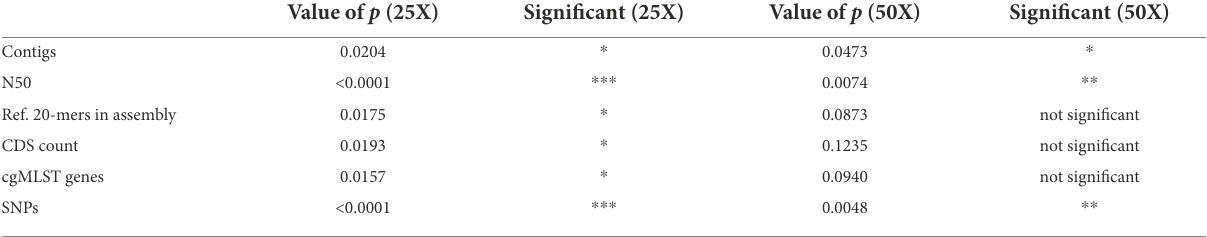
TABLE 2 t-tests comparing Nextera XT labs with Nextera Flex/DNA Prep labs for the quality control data from Figure 1 at coverages 25X and